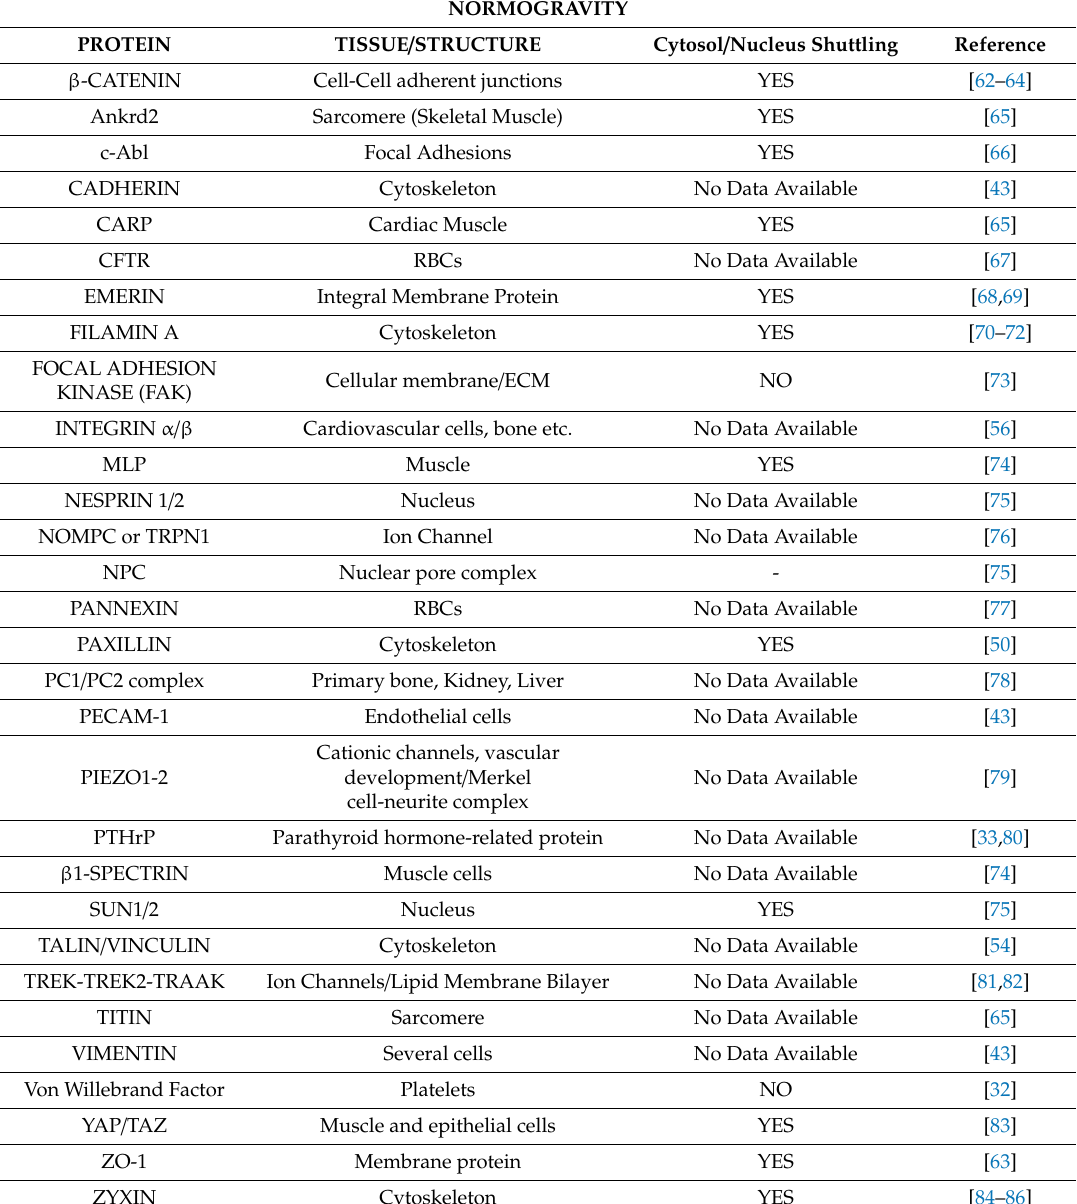
Table 1. List of mechanosensors in normogravity conditions and cytosol / nucleus shuttling.